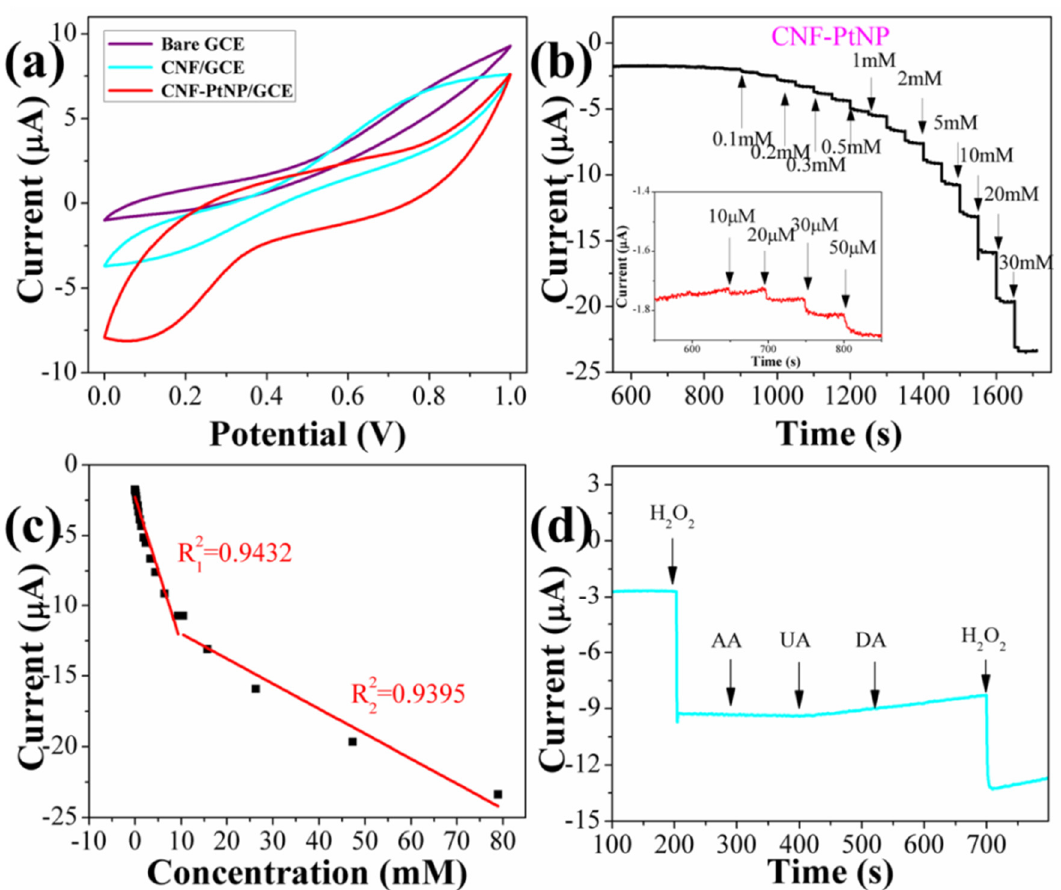
Figure 7. Electrochemical detection of H 2 O 2 : ( a ) Cyclic voltammograms (CVs) of glass carbon electrode (GCE) and GCEs modified with CNFs and CNF-PtNP hybrids; ( b ) I-T response of CNF-PtNP modified GCE; ( c ) Calibrated line; and ( d ) Selectivity of